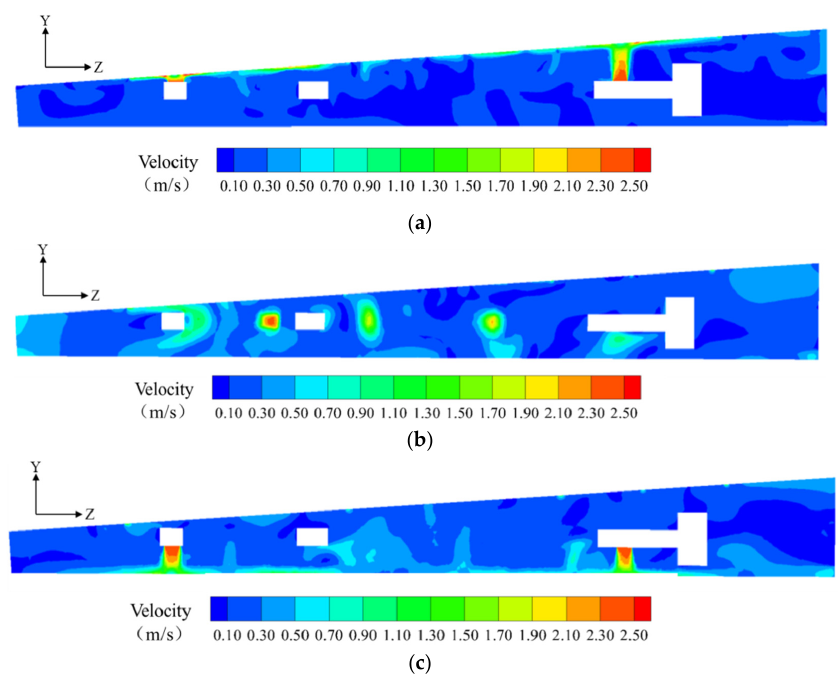
Figure 12. Velocity contours of plenum at section x = 7.62 m. ( a ) case B, ( b ) case C, ( c ) case D.